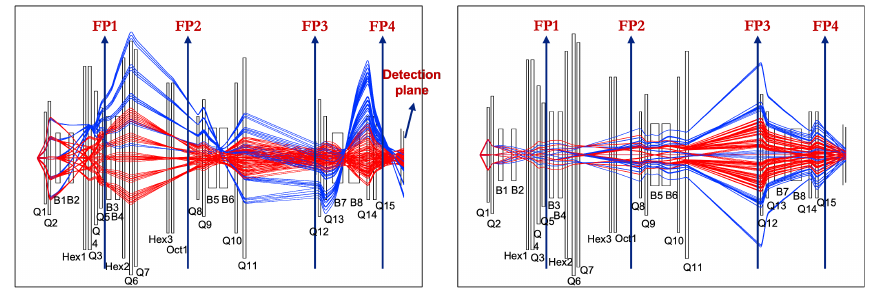
Figure 2. The ion optics of SECAR for the (p,n) measurement. The characteristic rays in the horizontal and vertical planes are shown in the left and right panel, respectively. The red lines represent the 58 Co 22 + recoils, and the blue ones the unreacted 58 Fe 22 + ions. The arrows show the focal plane positions where the existing mass slits were used to cut down the majority of the unreacted